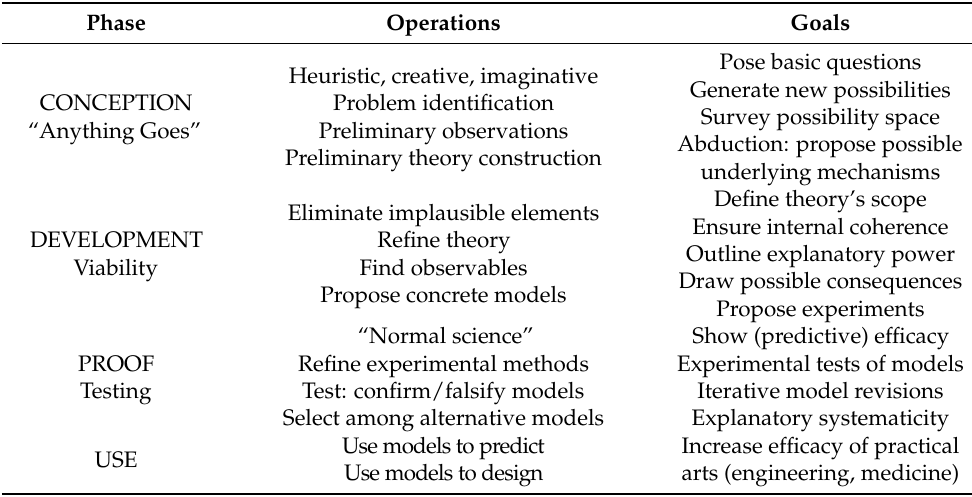
Table 1. Proposed stages of theories and models in experimental